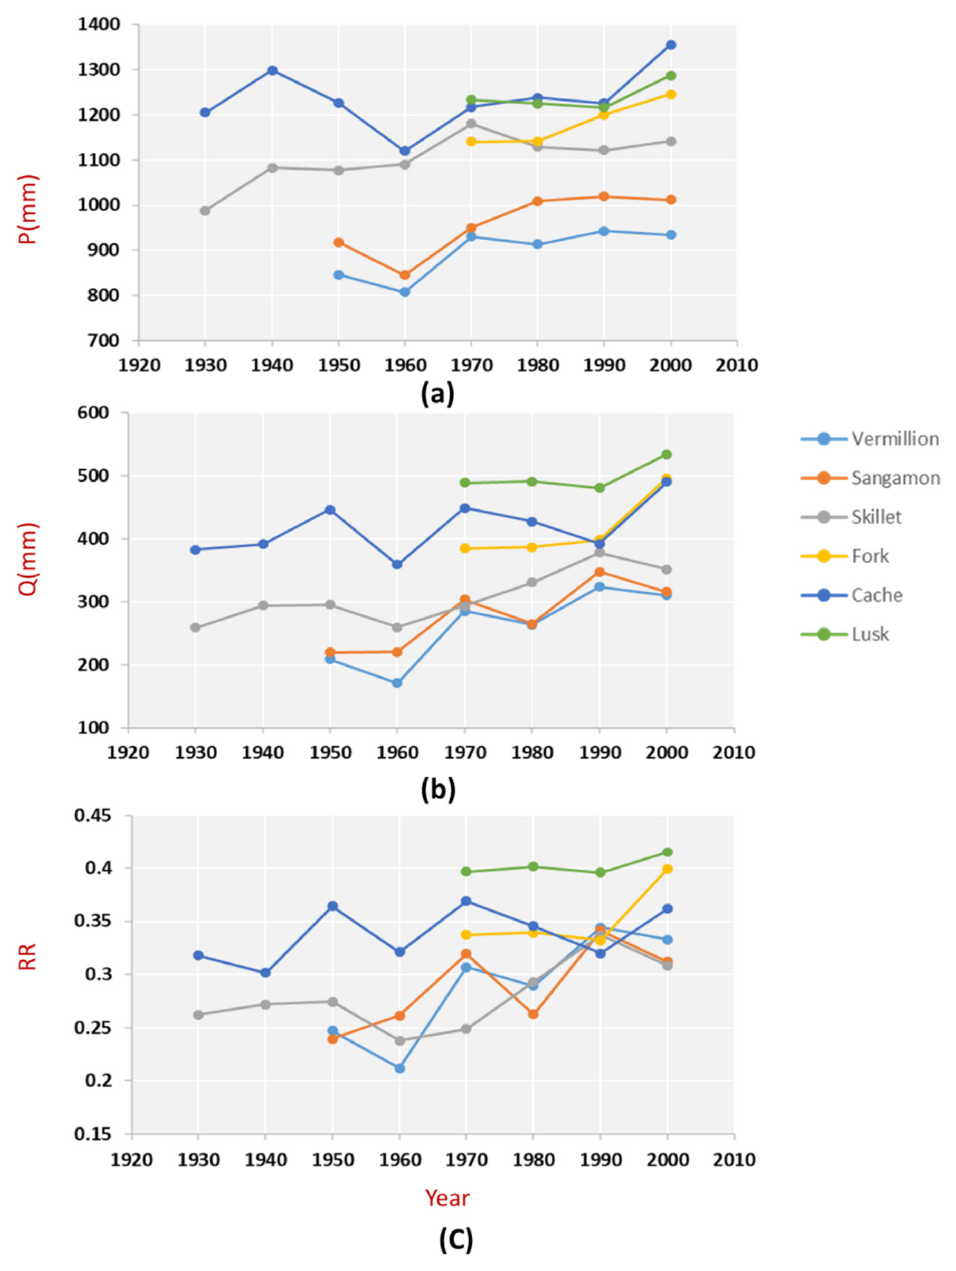
Figure 4. Decadal average of the ( a ) precipitation (P), ( b ) runoff (Q), and ( c ) runoff ratio